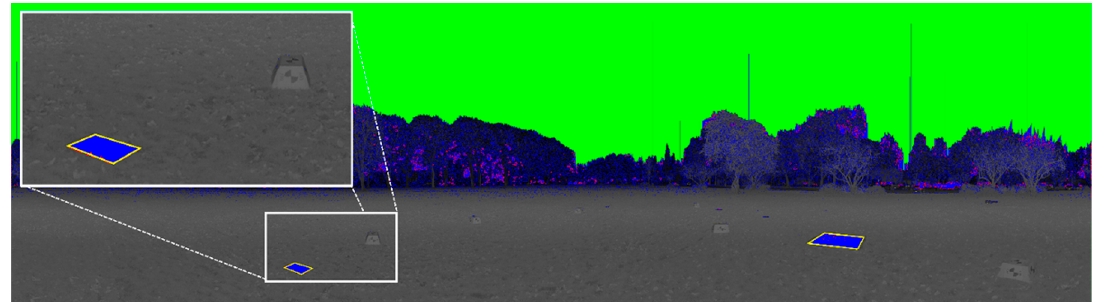
Figure 5. Example of a TLS 2D image with data gaps (blue), flagged dropout boundaries (yellow), and top and bottom vertical scan (green).